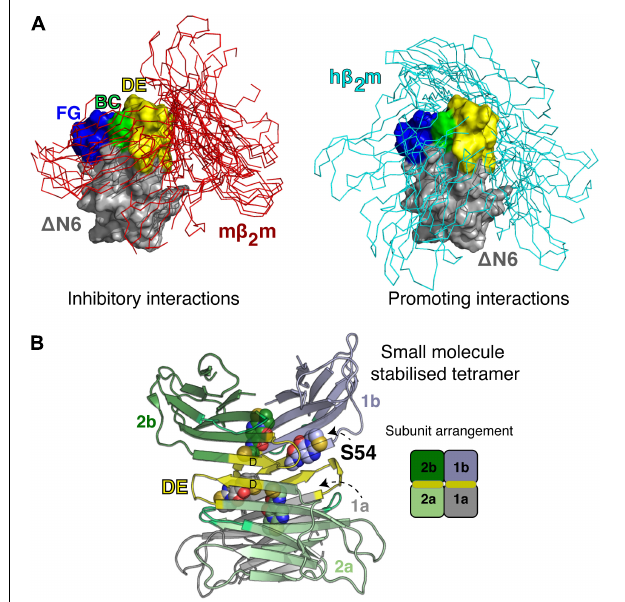
FIGURE 5 | Transient and stable forms of β 2 m oligomers. (A) Ensembles showing the dynamic nature of the (cid:49) N6-m β 2 m (left) and (cid:49) N6-h β 2 m (right) interactions (Karamanos et al., 2014). (cid:49) N6 is shown as a C α trace with the BC (green), DE (yellow) and FG (blue) loops highlighted (space fill). Note that the BC loop contains the trans Pro32. H β 2 m and m β 2 m are shown in a surface representation (gray) bound to (cid:49) N6. Ensembles of 100 complexes (aligned on (cid:49) N6) are shown. (B) A small molecule stabilized tetramer of (cid:49) N6 (7AFV) (Cawood et al., 2020). (cid:49) N6 subunits are shown as cartoons and the four copies of the covalent small molecule (S54; Cawood et al., 2020) are highlighted as spheres. The DE loop that is involved in one of the tetramer interfaces is shown in yellow and a schematic of the subunit arrangement in the tetramer is shown on the